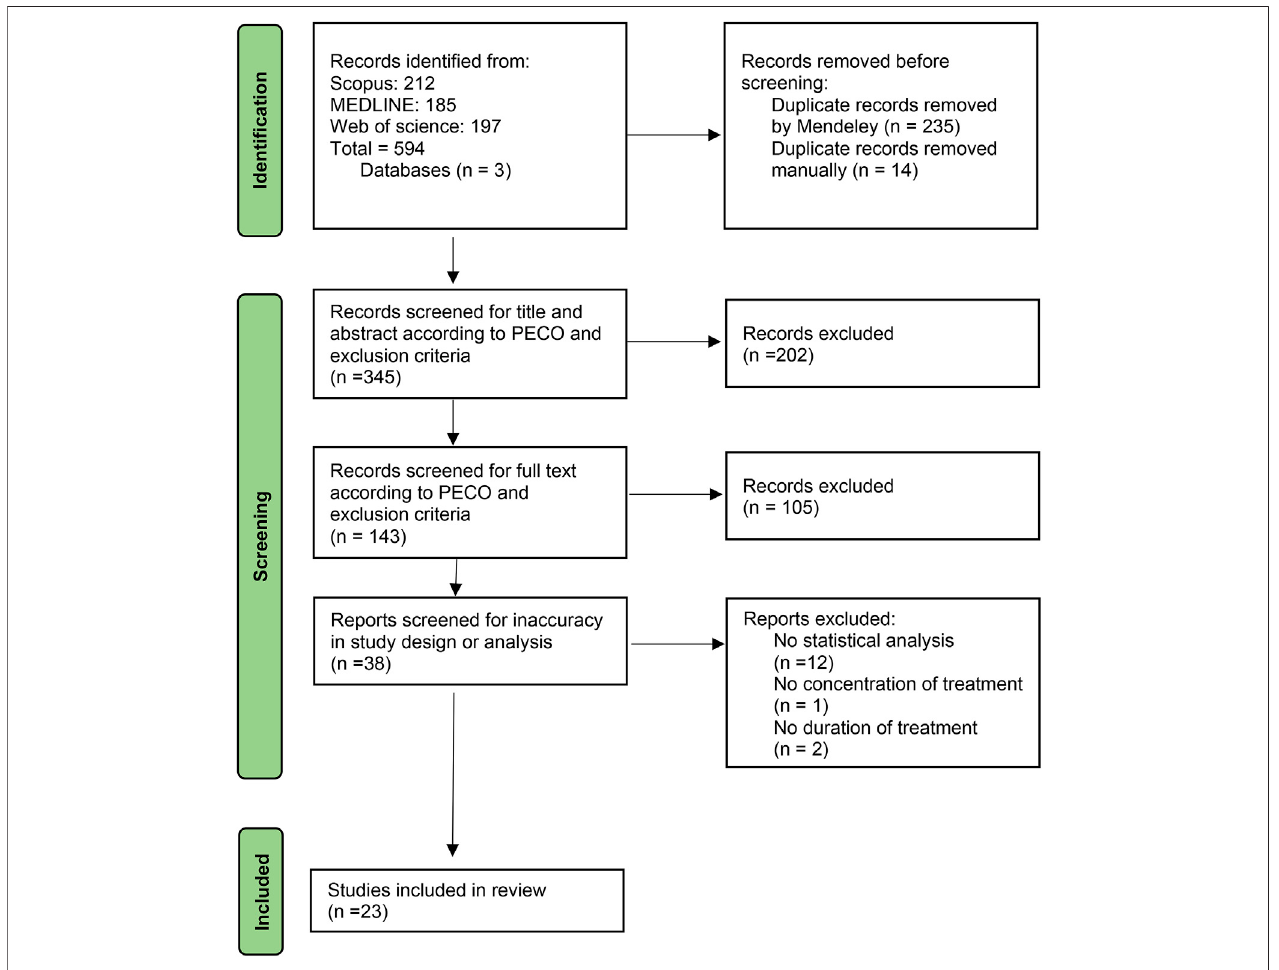
FIGURE 1 | Flow chart of study inclusion and exclusion steps and study selection. PECO: Population, Exposure, Comparison, Outcome